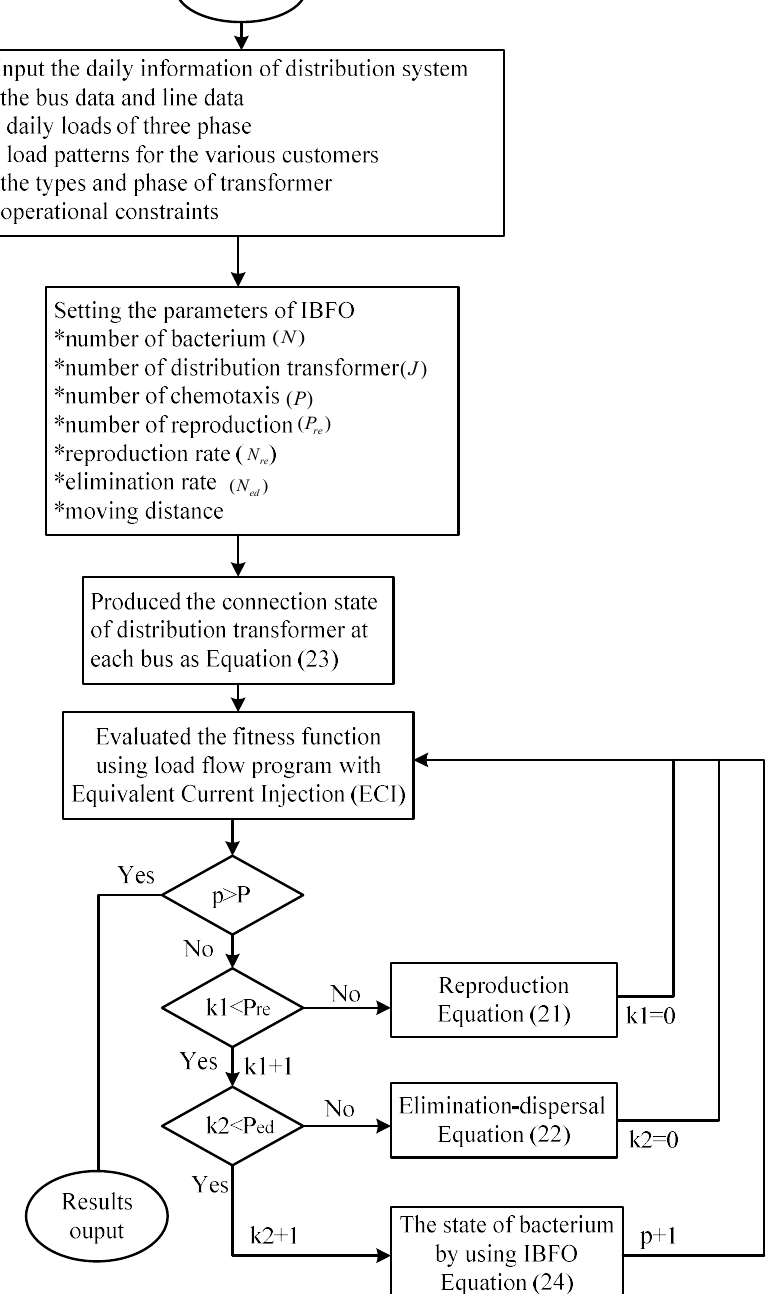
Figure 2. The flowchart of improved bacterial foraging algorithm (IBFO) applied.